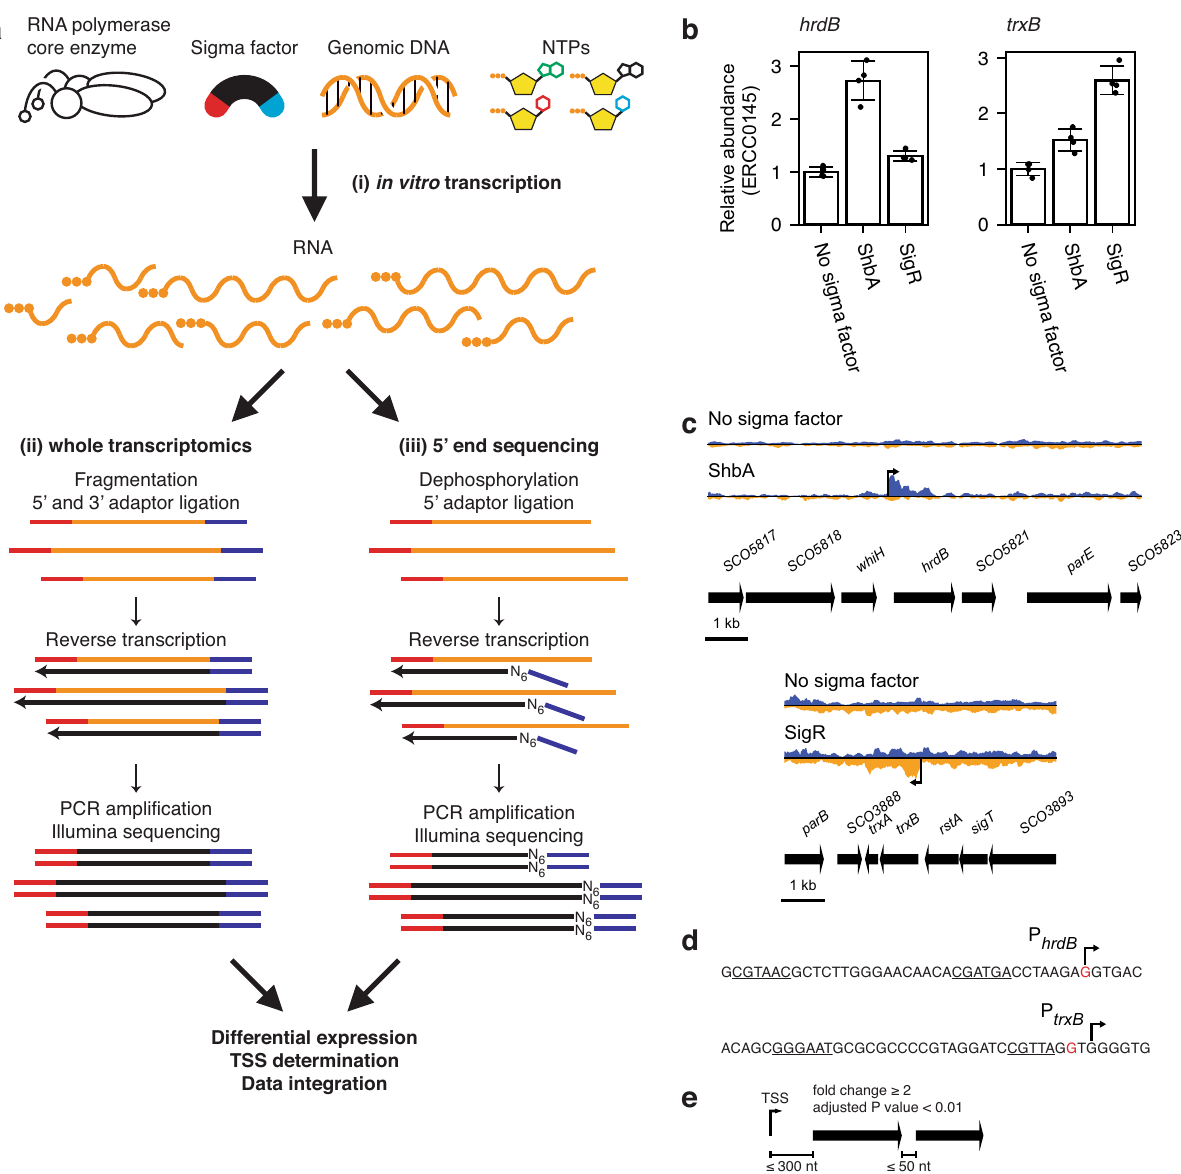
Fig. 1 Development of RIViT-seq. a Scheme of RIViT-seq. RIViT-seq consists of (i) in vitro transcription assay, (ii) whole transcriptomics and (iii) 5 ′ -end sequencing. b Veri fi cation of the in vitro transcription reactions with ShbA and SigR by quantitative RT-PCR. The ERCC0145 transcript was used as the normalisation control. Values are relative abundances of the hrdB and trxB transcripts of the samples with ShbA or SigR compared to the mean abundance of the “ No sigma factor ” samples. Error bars are standard deviations ( n = 4 independent experiments). c Transcriptional pro fi le of the hrdB and trxB loci. In blue and orange are normalised read counts on the sense (left to right) and antisense (right to left) strands, respectively, of the in vitro transcripts detected by whole transcriptomics. Bent arrows are TSSs of the in vitro transcripts detected by 5 ′ -end sequencing. d Promoter of hrdB recognised by ShbA (upper) and trxB recognised by SigR (bottom). Bent arrows are TSSs determined by 5 ’ -end sequencing. Red letters indicate previously identi fi ed TSSs. Underlined letters are previously determined – 35 and – 10 regions. e Criteria used to determine target genes and operons. Fold changes and adjusted P values were determined by using the DESeq2